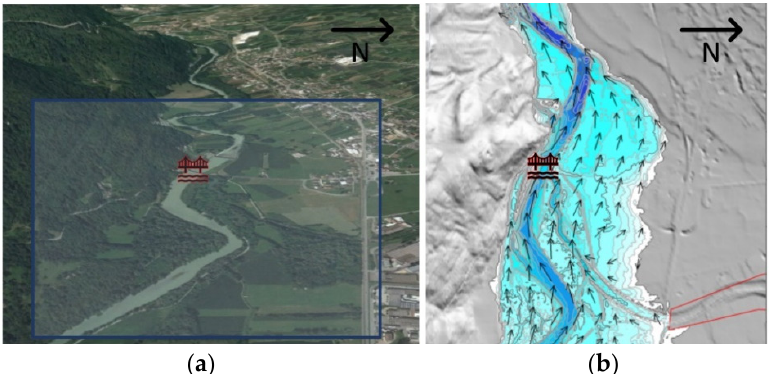
Figure 4. ( a ) View from upstream of Adda River crossed by the bridge. The blue rectangle highlights the 2D model domain of figure ( b ). The arrows indicate the direction and intensity of the current velocity, up to 3.7 m/s for the event T = 200 years. Note the expansion of the river in the right floodplain.